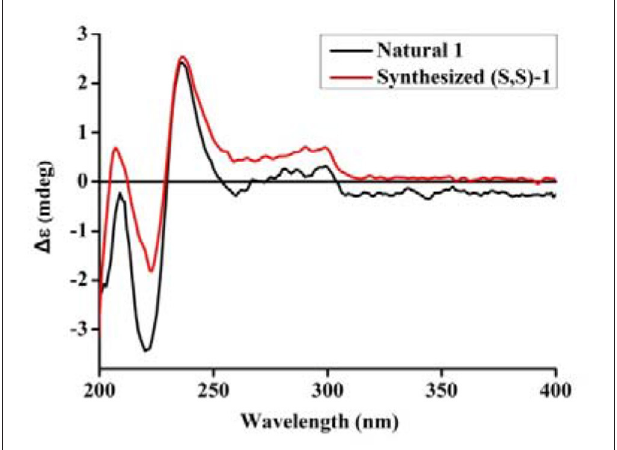
FIGURE 3 | CD spectrum of synthesized ( S , S )- 1 and natural 1